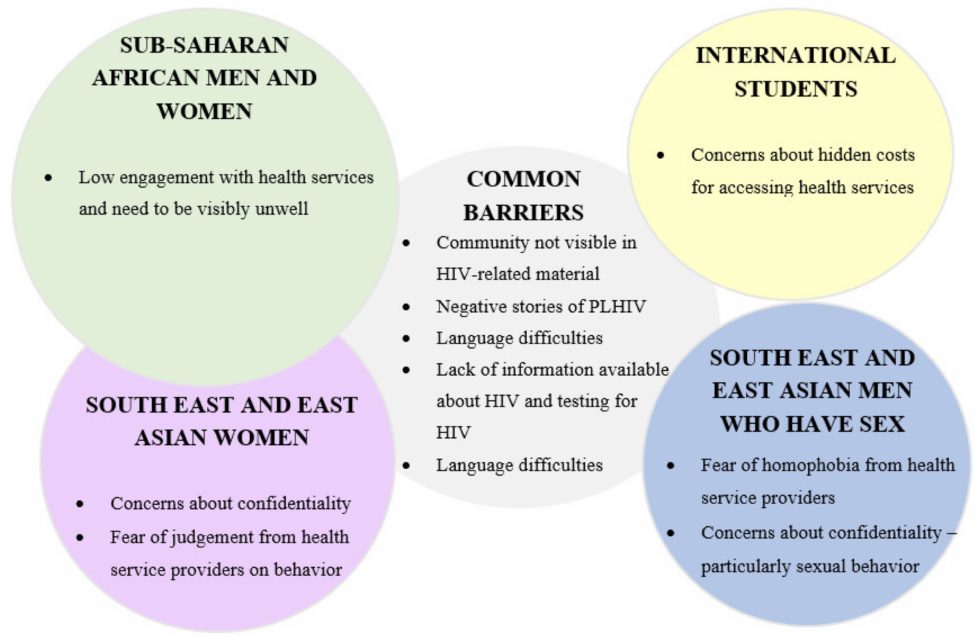
Figure 2. Barriers to HIV testing—commonalities and differences across